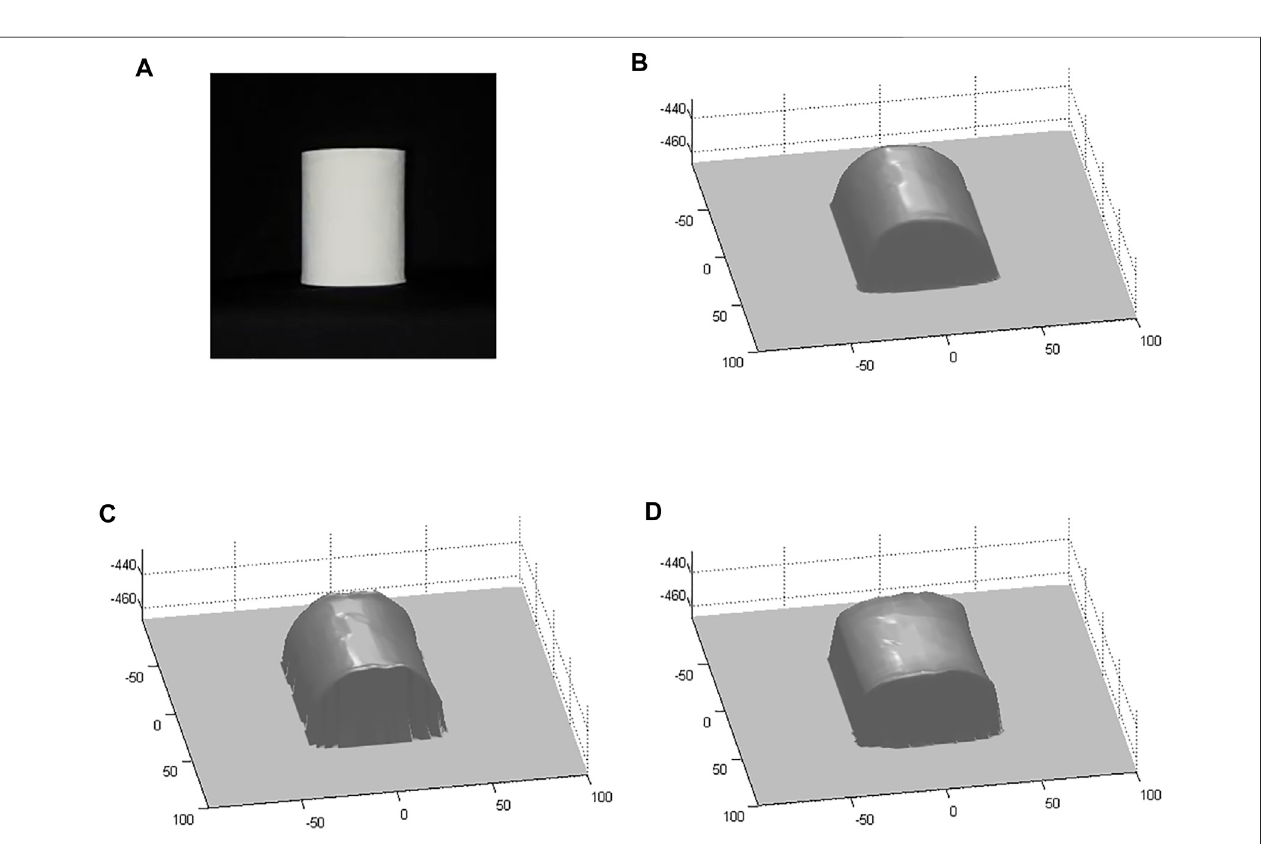
FIGURE 3 | Real-world shading image and reconstructed surface. (A) Shading image, (B) Reconstructed surface by Vogel and Cristiani ’ s approach, (C) Reconstructed surface by our proposed approach, and (D) Reconstructed surface by our proposed approach with Lambertian re fl ectance.